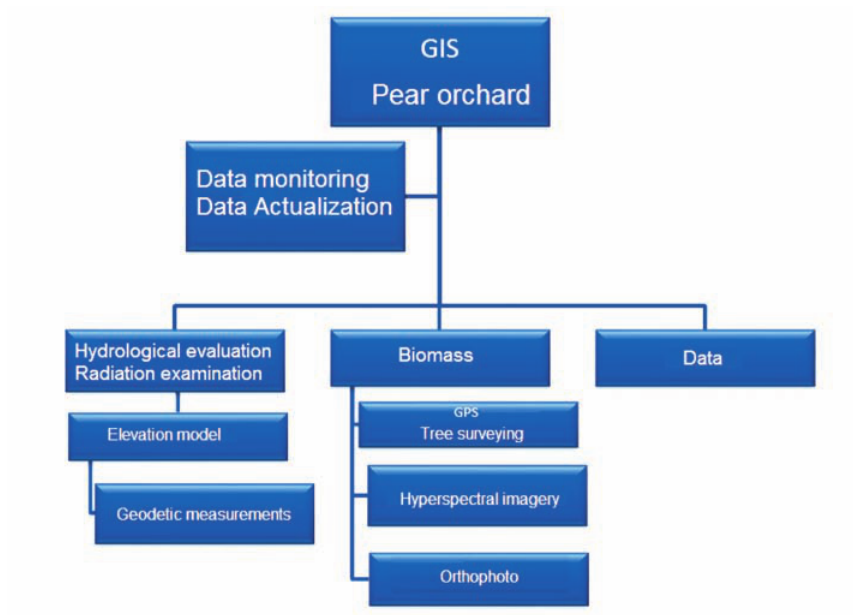
Figure 3. Conceptual data model of pear